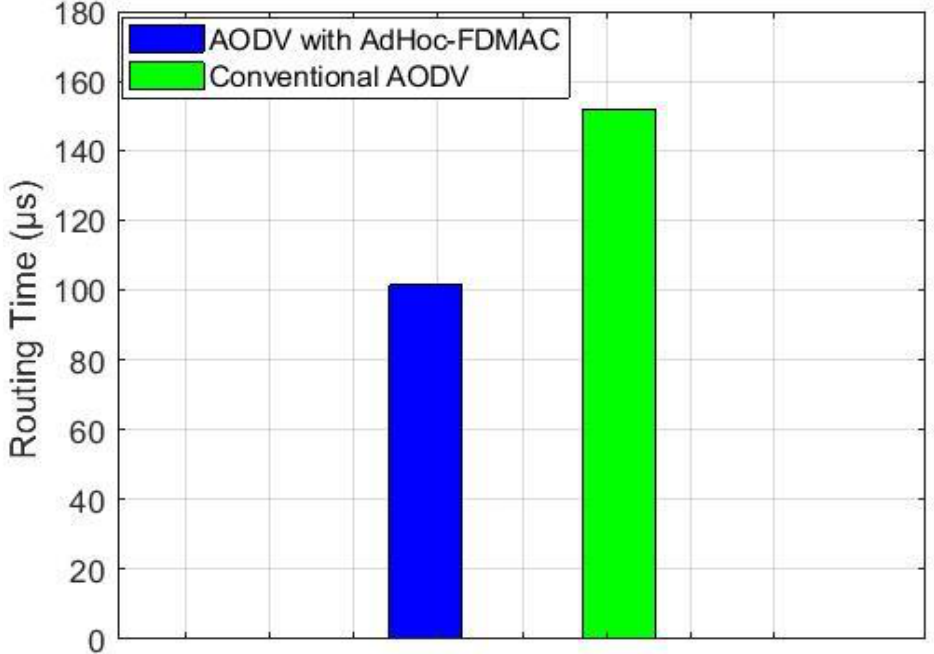
Figure 11. Routing time comparison.